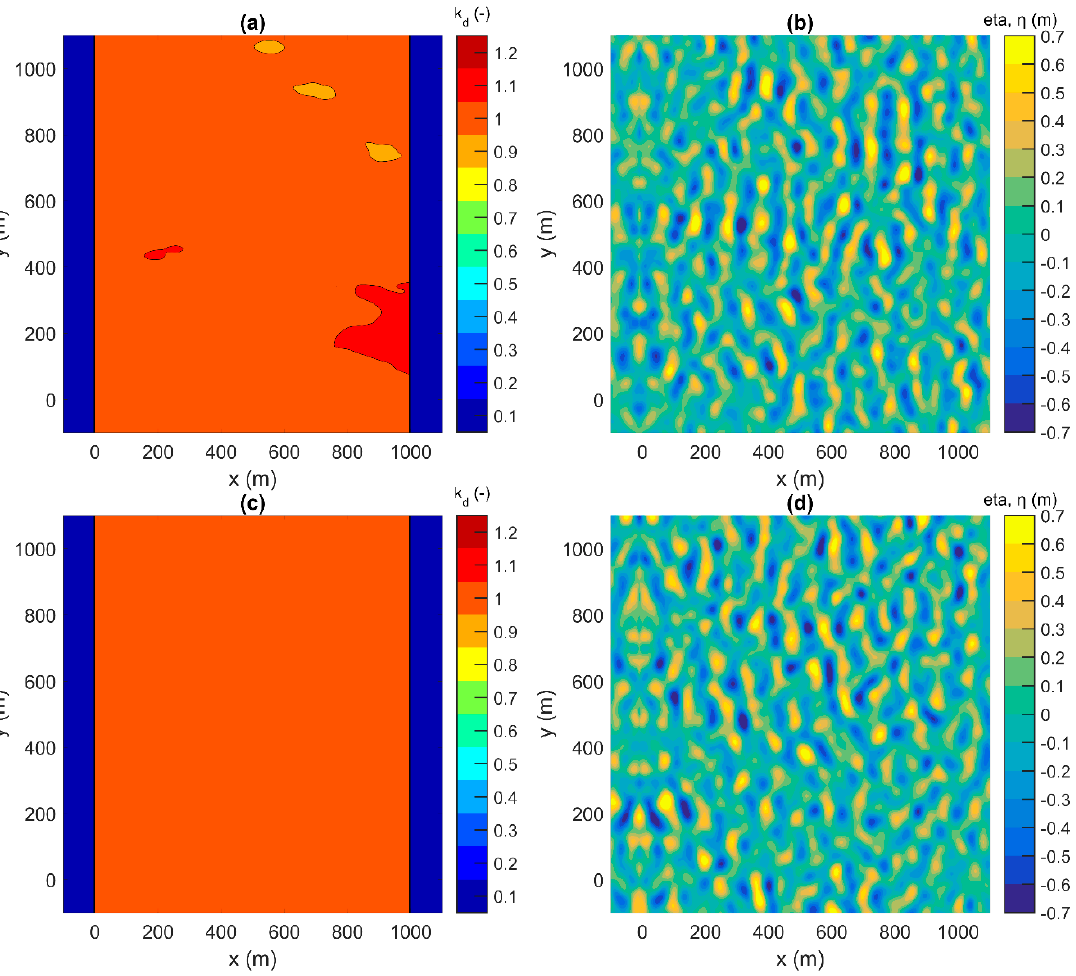
Figure 11. Disturbance coefficient, k d , and water surface elevation, η , in the inner computational domain at t = 7000 s for irregular short crested waves with H s = 1 m, T p = 12 s, θ = 0 ◦ , and σ θ = 30 ◦ , synthesized by using the Miles method ( a , b ) and the Sand and Mynett method ( c , d ).